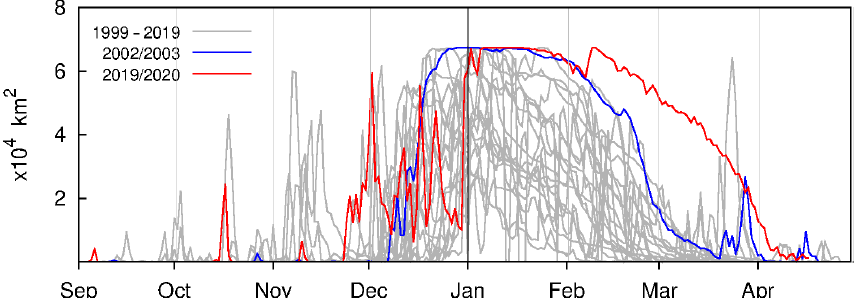
Figure 3. Ice-shelf melt area. The 1999–2019 curves are based on the three sets of scatterometer data: SIR QuikSCAT, SIR ASCAT, and Level 1 ASCAT.